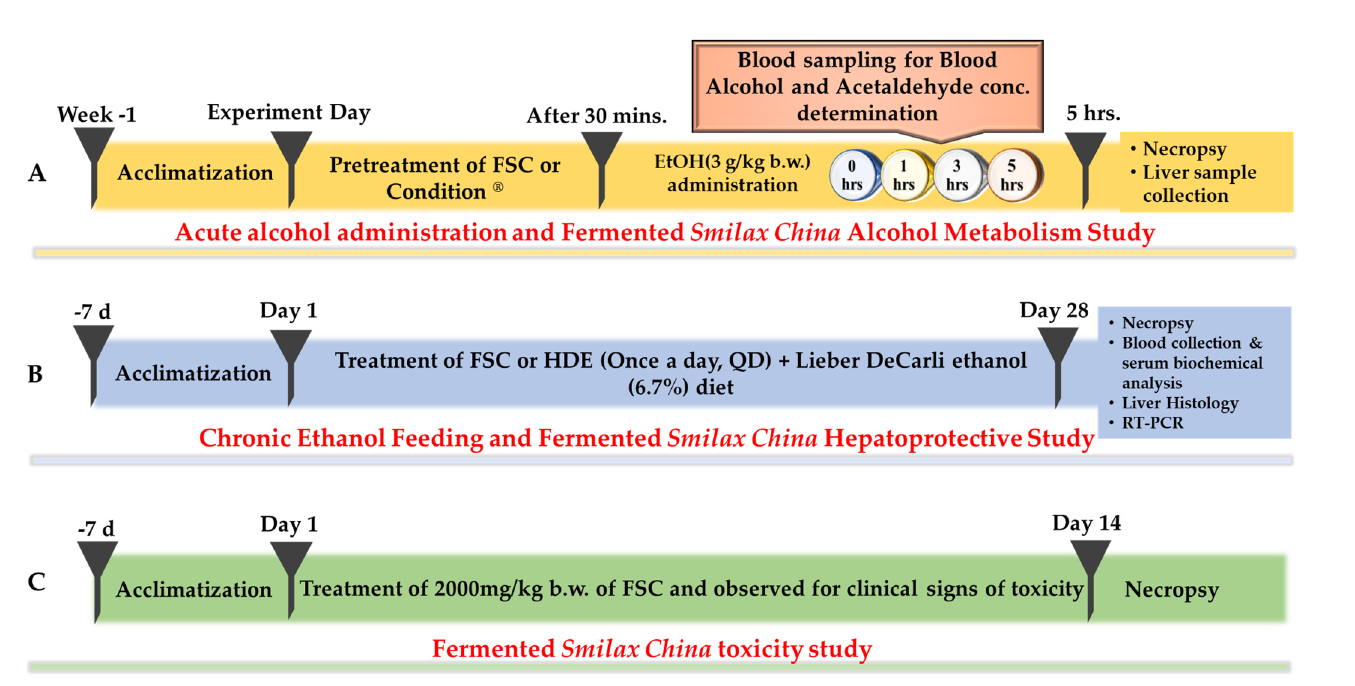
Figure 1. In vivo experimental design: ( A ) The rats were pretreated with different doses of fermented Smilax china extract (FSC) prior to the oral administration of ethanol (3 g/kg b.w.). Then, blood samples were collected at different time intervals (0, 1, 3, and 5 h), and alcohol metabolism-associated effects of FSC were studied. ( B ) The different groups of rats were fed Lieber-DeCarli ethanol (6.7%) diet with or without FSC pretreatment (once daily) for 28 days. After sacrifice, the hepatoprotective effects of FSC were studied. ( C ) The acute toxicity of FSC was studied; bolus 2000 mg/kg b.w. of FSC was administered to female rats, and the rats were observed over 14 days.